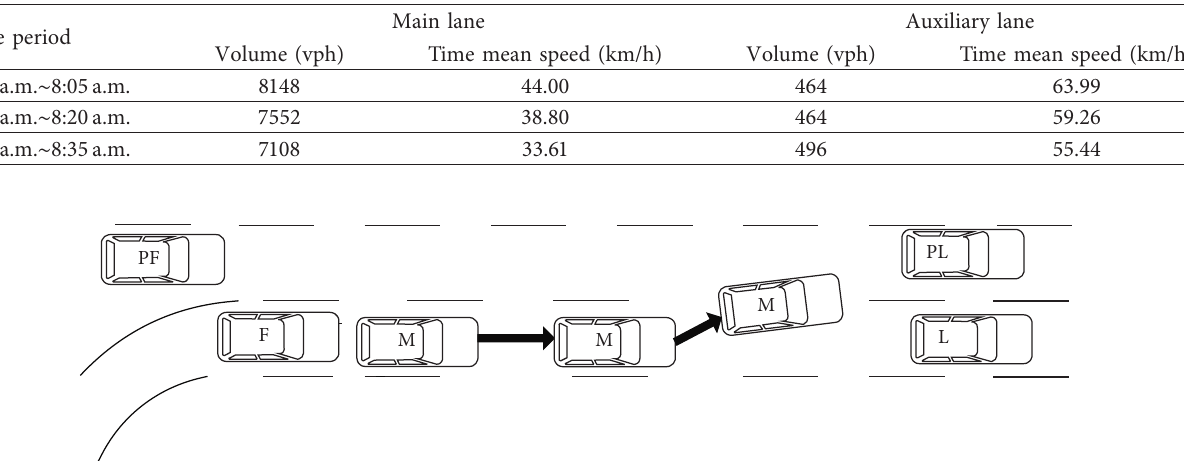
Figure 3: Merging decision during from the start to the end of the execution process.